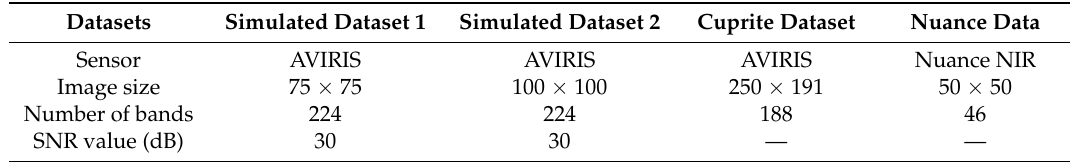
Table 1. Basic information about the four experimental